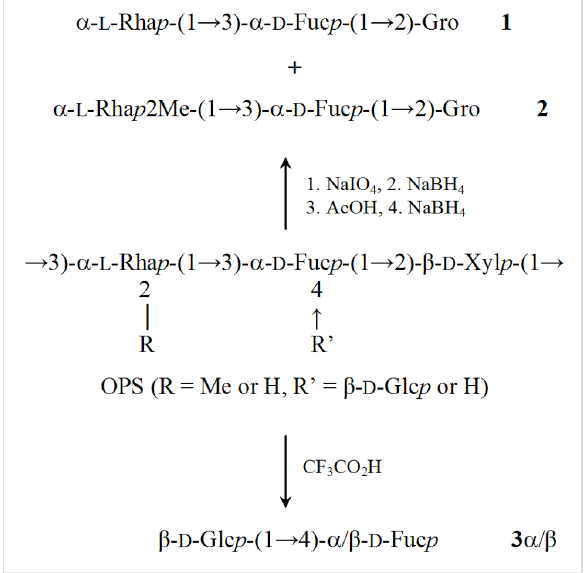
Scheme 1: Structures of the OPS from A. halopraeferens Au4 and oligosaccharides obtained from the OPS by Smith degradation ( 1 and 2 ) and solvolysis ( 3 ). Gro indicates glycerol.